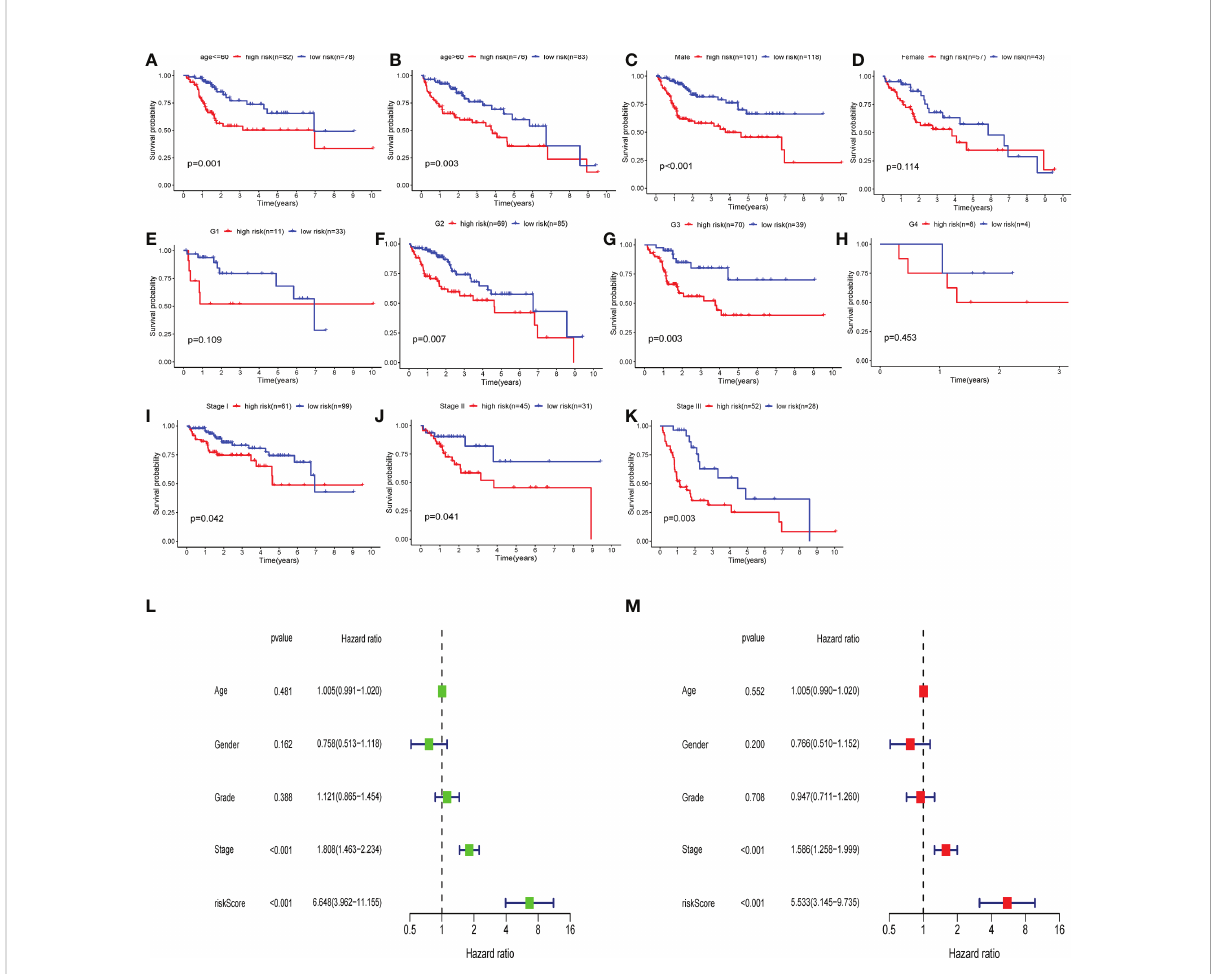
FIGURE 10 Independent predictive analysis and subgroup analysis of CSRGPI. The subgroup survival analysis was strati fi ed by age (A, B) , gender (C, D) , grade (E – H) , and stage (I – K) to further con fi rm the risk strati fi cation ability of CSRGPI. (L, M) Forest plot visualization of univariate and multivariate cox regression results in the TCGA-HCC